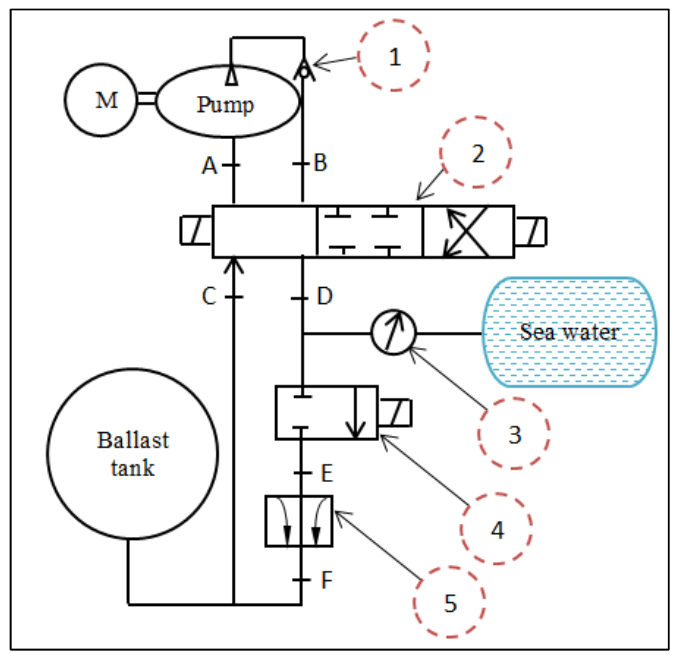
Figure 7. Basic circuit diagram of the proposed VBS: 1. check valve, 2. four way-three position valve, 3. flow rate gauge, 4. two way-two position valve and 5. flow control valve.